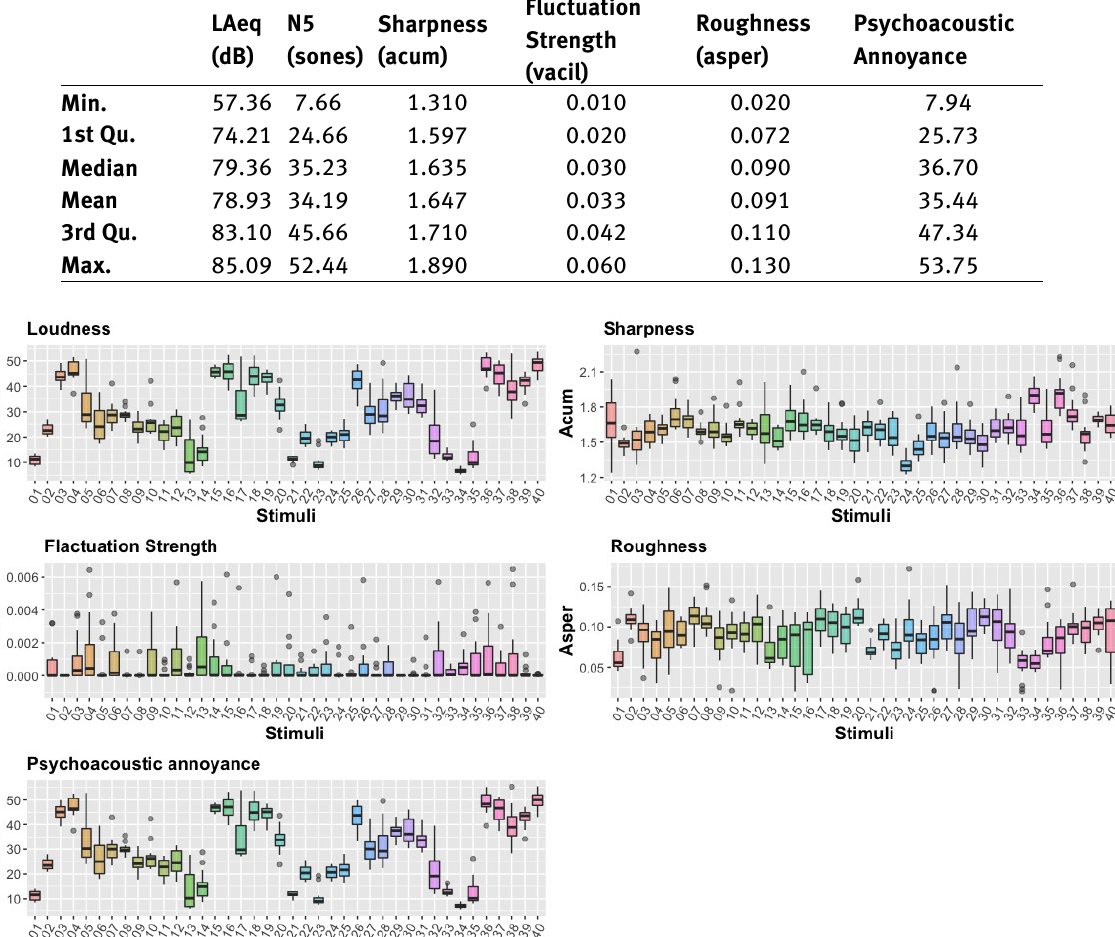
Table 2: Statistical summary of psychoacoustics indicators.